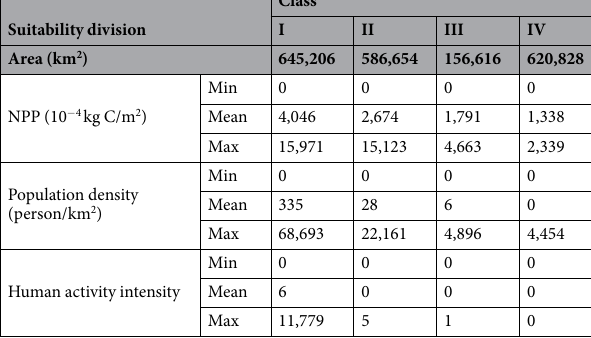
Table 4. Characteristics analysis of environmental suitability regions of China’s CCS site selection.